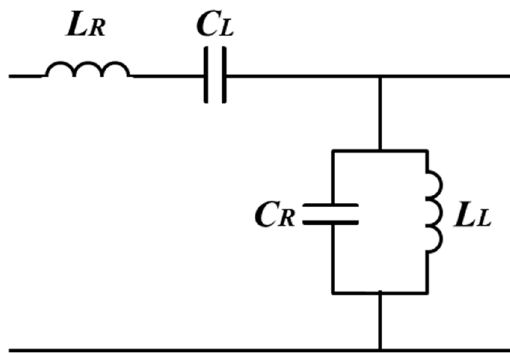
Figure 7. Equivalent circuit of composite right / left-handed (CRLH) transmission line.